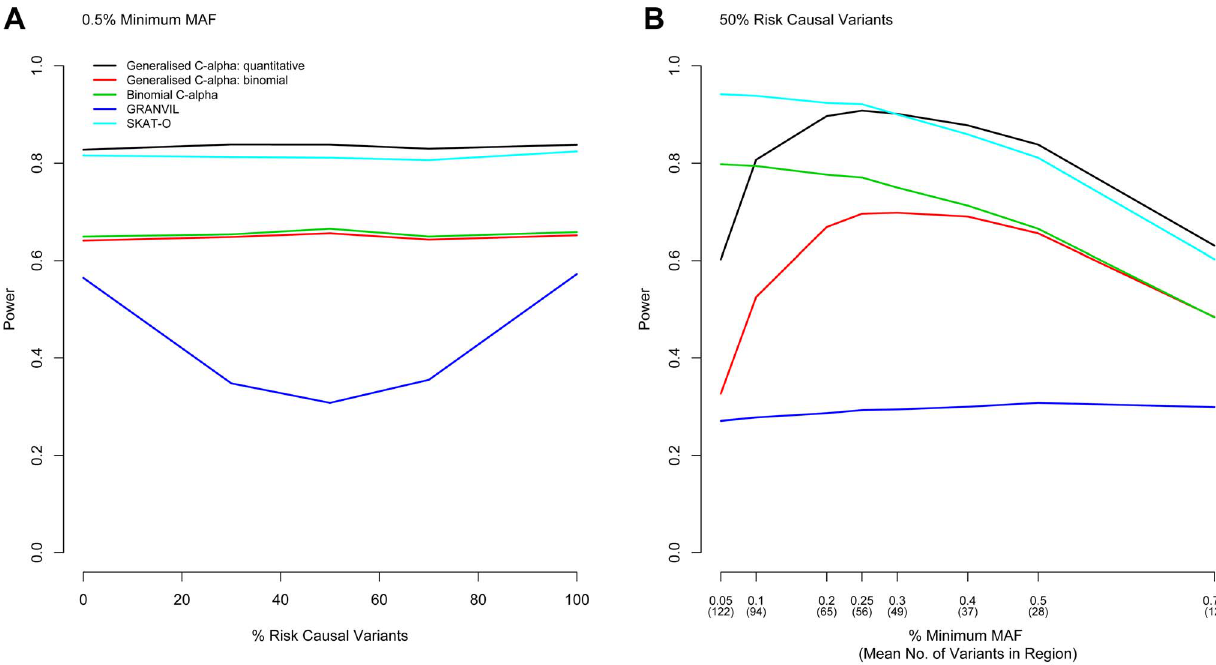
Figure 1. Power Comparisons. Power to detect association in a region is shown for the Generalised C-alpha test, SKAT-O and the GRANVIL test applied directly to the quantitative trait and for the Generalised C-alpha and the Binomial C-alpha tests applied to the dichotomised quantitative trait. (A) Power is shown as a function of the percentage of causal variants in a region of size 100 kb that are risk as opposed to protective when the minimum MAF of variants considered is fixed at 0.5% for a sample size of 10,000. Results show that as the proportion of risk causal variants approaches 50%, the C-alpha and SKAT-O tests maintain power and that the Generalised C-alpha applied directly to the quantitative trait has optimal power. (B) Power is also shown as a function of the minimum MAF of variants considered when the percentage of risk causal variants in a region of size 100 kb is fixed at 50% for a sample 10,000 individuals. Results show that the power of the Generalised C-alpha test is optimal for variants with MAF . , 0.3% but SKAT-O is optimal for lower MAF. For quantitative traits, the power of the Generalised C-alpha test remains better than the Binomial C-alpha applied to a dichotomized version of the trait as long as variants have MAF . , 0.1%. For binary traits, the Binomial C-alpha test has greater or equivalent power than the Generalised C-alpha